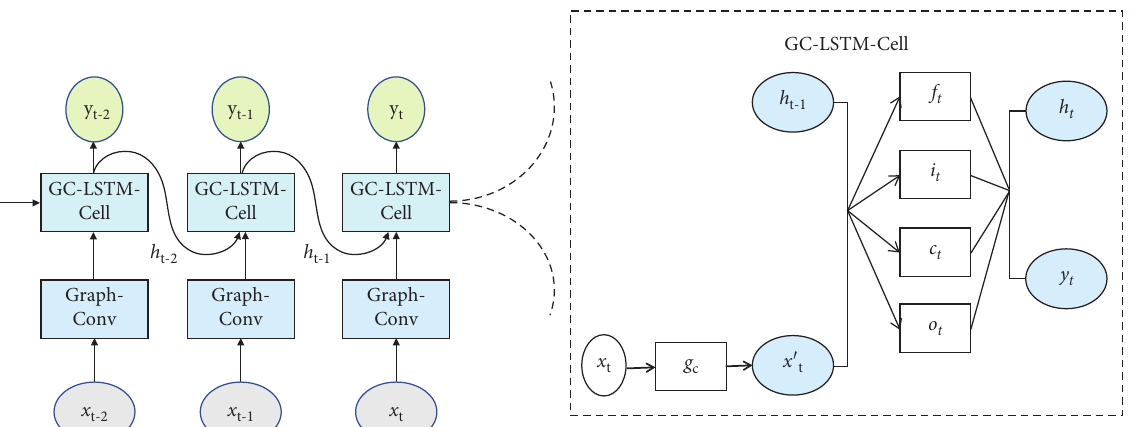
Figure 2: The architecture of the GCN-LSTM model. i state.